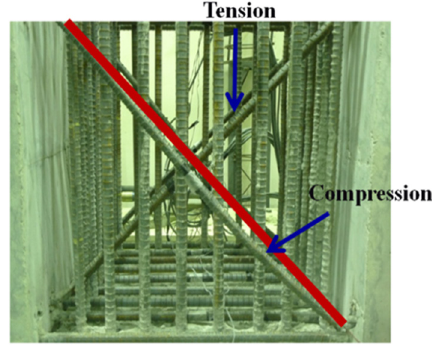
Fig. 14. Buckling in X-braced rebar of PC